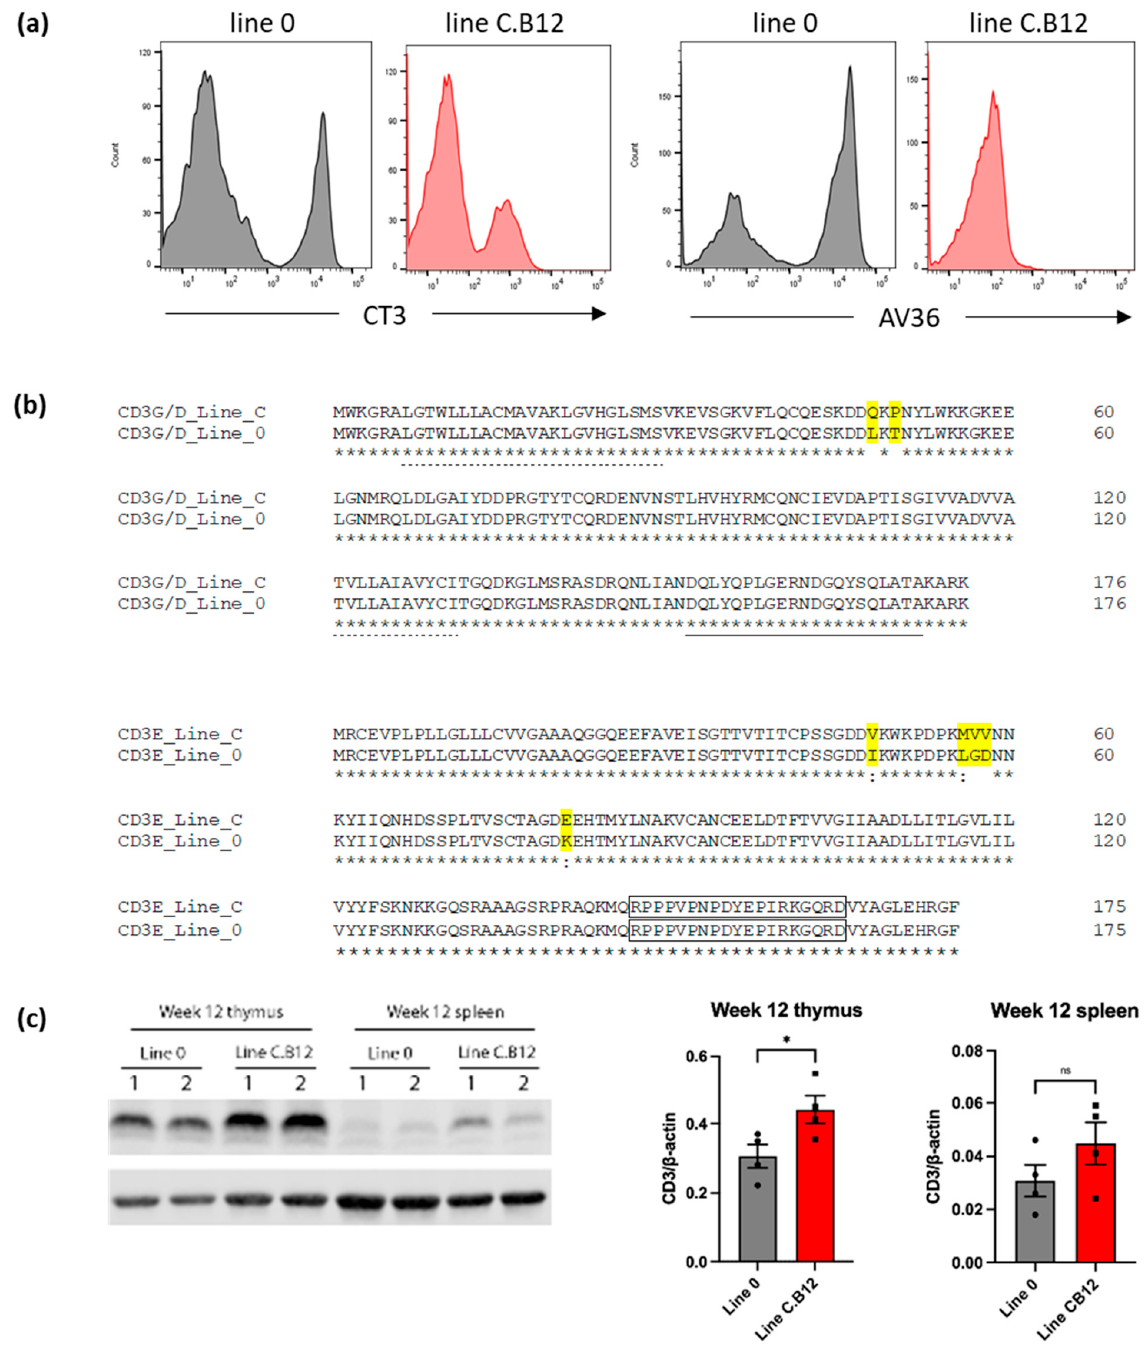
Figure 2. Polymorphisms in CD3 of line 0 and line C.B12 birds. ( a ) Flow cytometric analysis of splenocytes of 4-week-old line 0 (black) and line C.B12 birds (red), stained with mouse anti-chicken CD3 clone CT3 or mouse anti-chicken CD3 clone AV36. Cells were gated on 10,000 live, single CD45 + cells. Representative of five birds. ( b ) Comparison of the CD3 chains between line C and line 0. Dotted lines represent the transmembrane domain, and the underline represents an ITAM domain. Differences in the amino acid sequence between the lines are highlighted in yellow. The boxed area is the epitope recognised by the CD3-12 antibody. ( c ) Representative images of western blot analyses for lymphocytes from the lung, thymus and spleen of two 12-week-old line 0 and line C.B12 birds using the anti-CD3 ε clone CD3-12 (left panel). Quantitative analyses for CD3 levels relative to the actin from thymus (middle panel) and spleen cells (right panel) are shown. Data points are for cells collected from individual birds (n = four per line). * p < 0.05